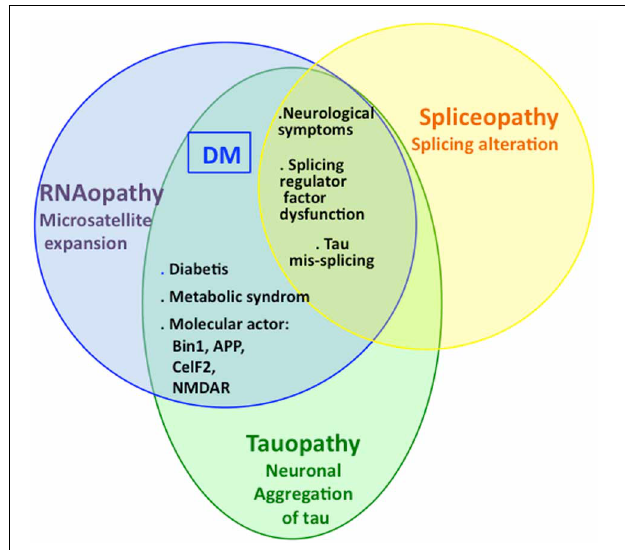
FIGURE 4 | The complex interaction between RNAopathy, spliceopathy, and tauopathy. DM diseases are the first pathologies for which these interactions have been